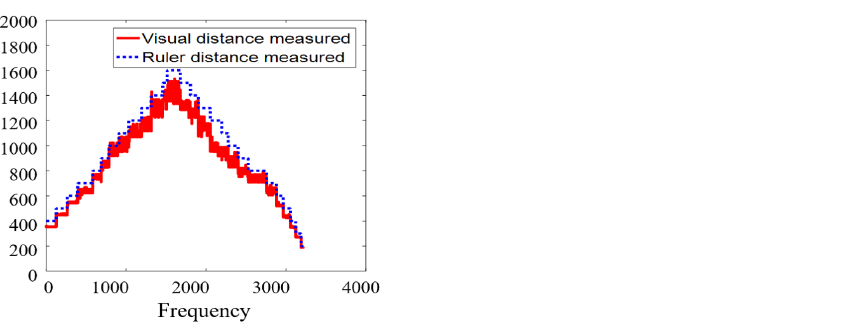
Figure 13. The scheme of the underwater Vision-based ranging experiment where the yellow subma- rine model moved 10 cm each stage.